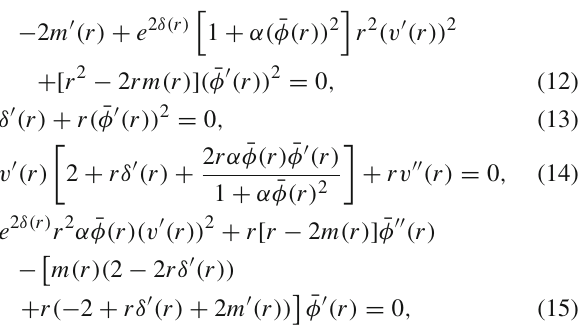
This approximate solution involves two parameters of φ 0